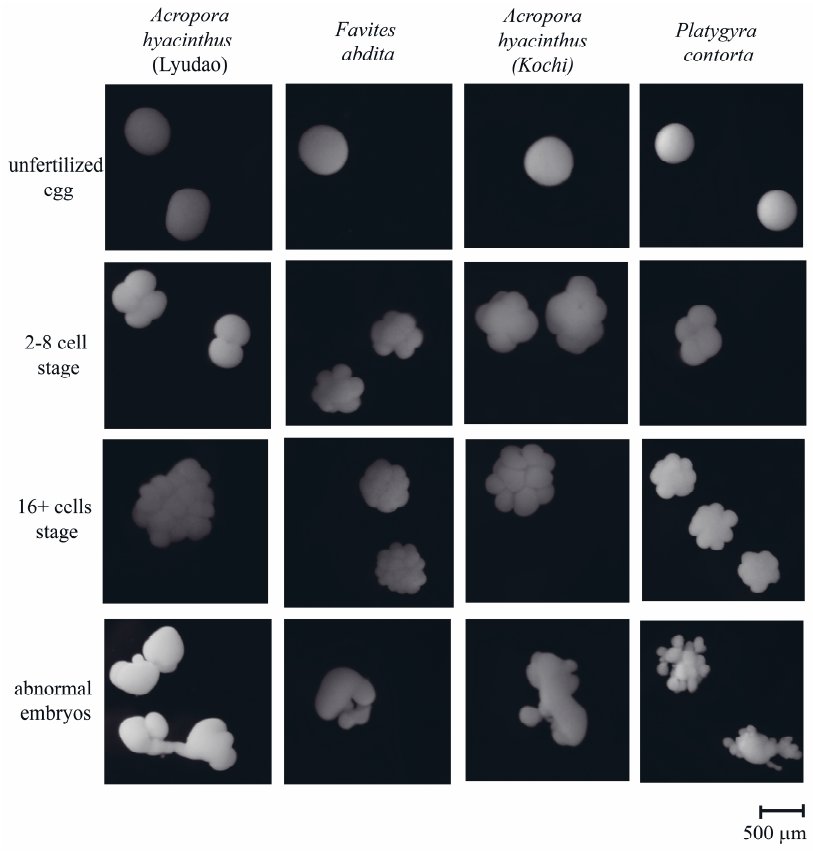
Figure 3. Representative pictures showing different stages of embryonic development and abnormal development of each coral species